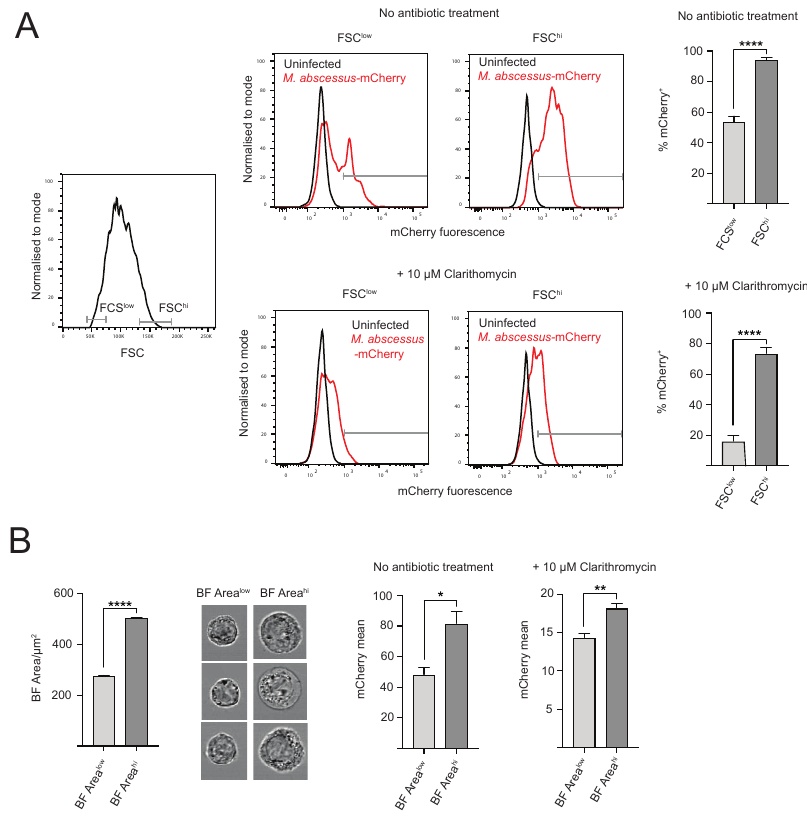
Figure 4. Host cell size correlates with bacterial load. ( A ) Conventional flow cytometry analysis of the influence of host cell size on % of infected host cells. Left: Gating strategy used to define cells with lowest (FCS low ) and highest (FCS hi ) size, defined based on FSC parameter. Right: Representative flow cytometry plots showing mCherry + gate in FCS low and FSC hi subpopulations in untreated and clarithromycin-treated macrophages. Graph showing the % Cherry + FSC low and FSC hi cells from untreated and clarithromycin-treated samples. Data from 3 independent experiments, with 3 experimental repeats per experiment. ( B ) Imaging flow cytometry analysis of the influence of host cell size on intracellular bacterial load within infected macrophages. Left: Brightfield (BF) area values for cells with 10–15% lowest (BF Area low ) and highest (BF Area hi ) values from population of mCherry + macrophages infected with M. abscessus -mCherry. Representative BF images of cells from BF Area low and BF Area hi subpopulations. Right: Mean pixel (mCherry) on BF Area low and BF Area hi subpopulations from mCherry + infected macrophage population from untreated and clarithromycin-treated samples. Data from 2 independent experiments, with 3 technical repeats per experiment. Unpaired t -test was used for analysis. * = p ≤ 0.05, ** = p ≤ 0.01, **** = p ≤